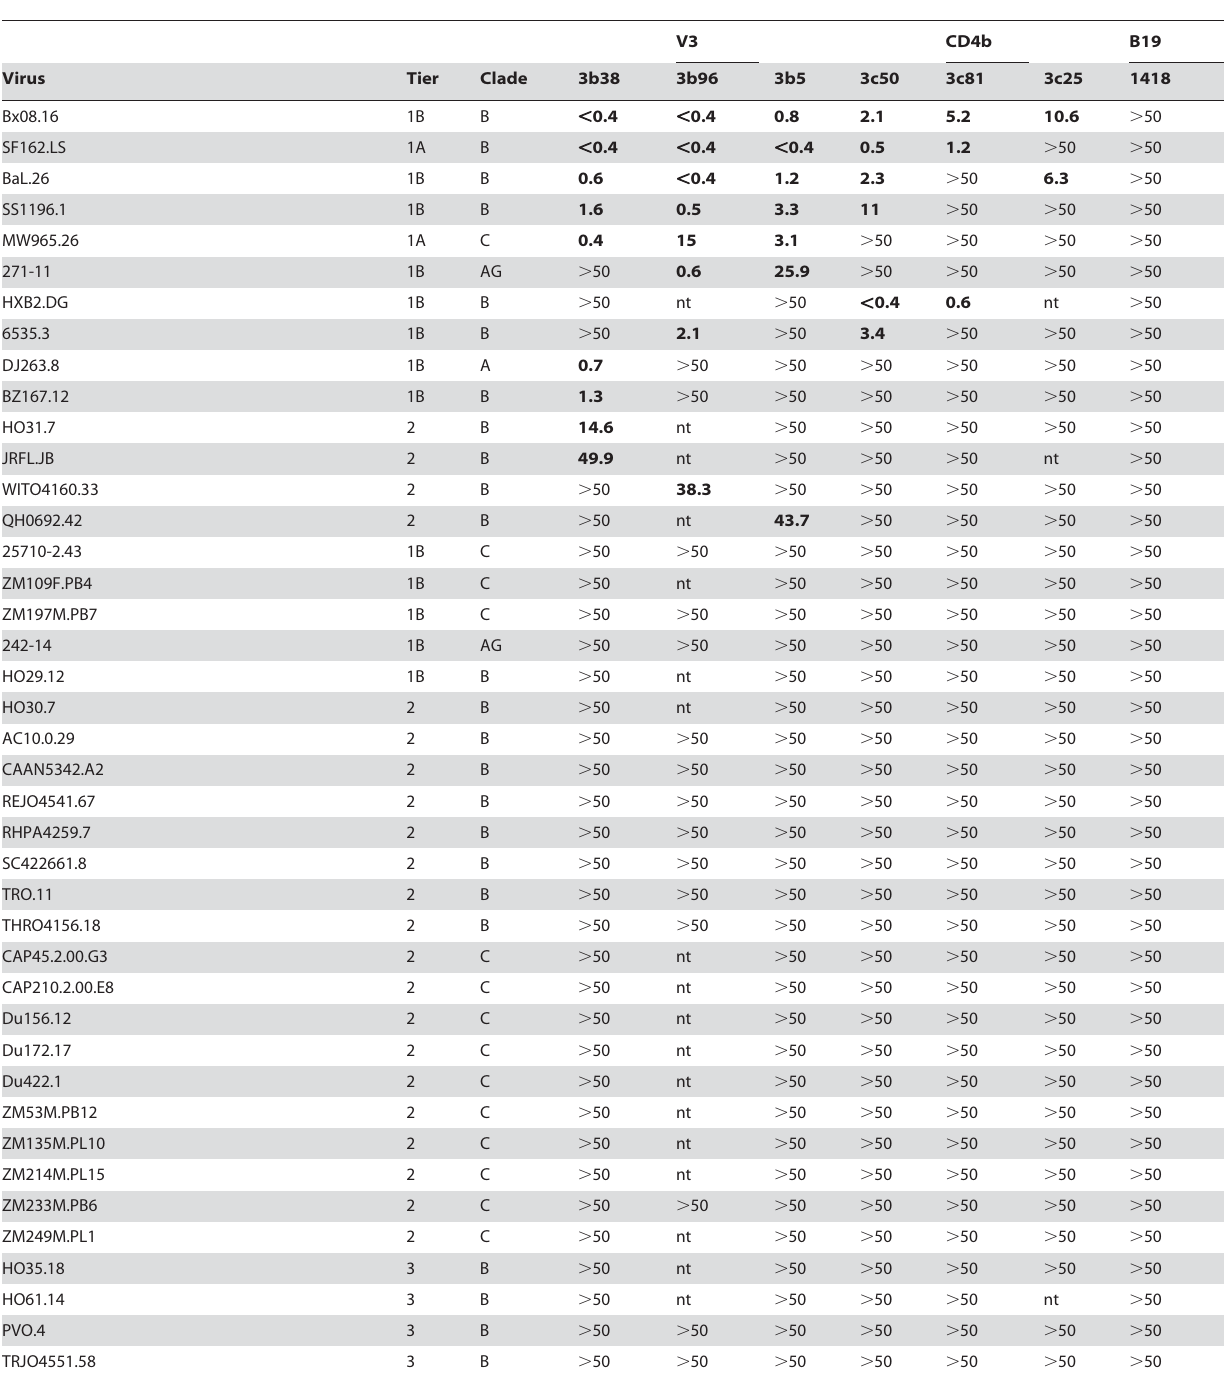
Table 3. Neutralization of pseudoviruses by anti-V3 and anti-CD4bs mAbs.